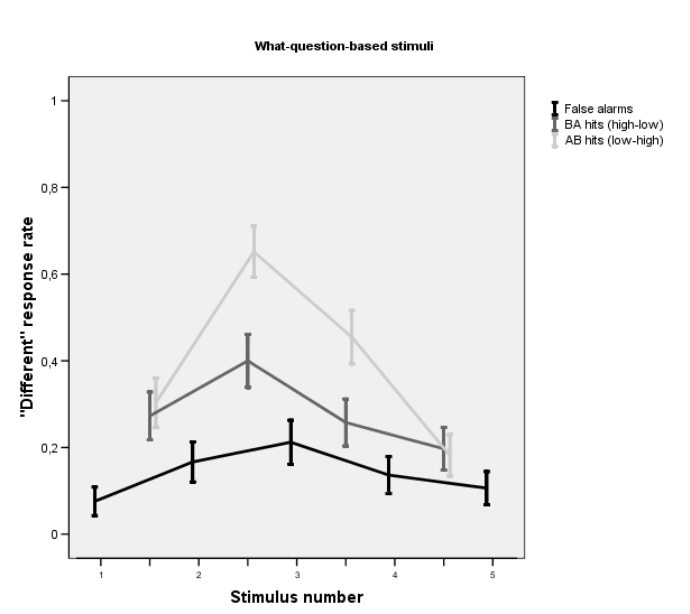
Figure 7. Rate of “different” responses for pairs that were actually different (hits) and pairs that were identical (false alarms) corresponding to the continuum created from the what-question base stimulus. Error bars represent standard error of the mean.